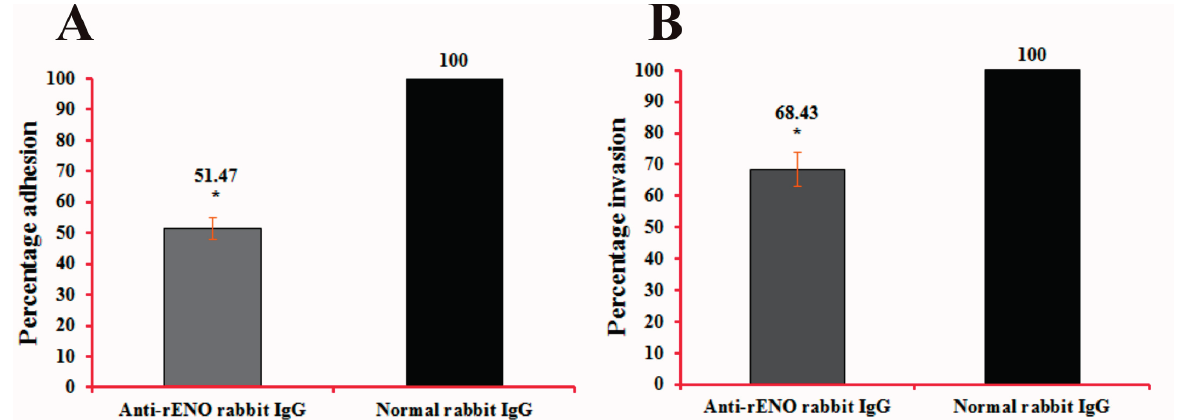
Figure 6. Adhesion ( A ) and invasion ( B ) analyses. Decrease in the adhesion to and invasion of BHK21 cells by S. iniae DGX07 through use of rabbit anti-rENO serum. S. iniae DGX07 was pre-incubated with the appropriate concentrations of antibodies (1:100) at 37 °C for 60 min prior to infection. The percentage of adhesion to and invasion of cells were 51.47% ( p < 0.05) and 68.43% ( p < 0.05) in experimental groups compared to control groups, respectively. Each treatment and control group test was performed in three replicate